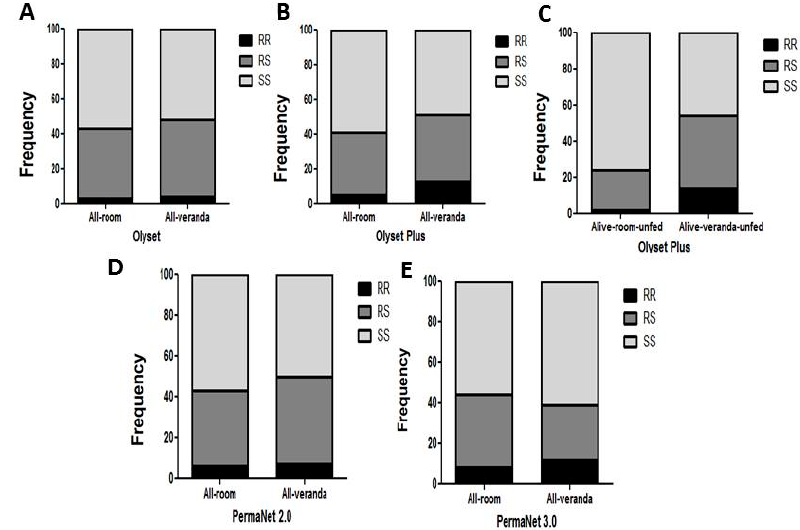
Figure 4. Impact of the L119F-GSTe2 mediated metabolic resistance on bednet efficacy -exophily: ( A ) Genotype distribution of L119F- GSTe2 between indoor (Room) and outdoor (verandah) mosquitoes after exposure to Olyset showing no association; ( B ) Genotype distribution of L119F- GSTe2 between indoor (Room) and outdoor (verandah) mosquitoes after exposure to Olyset Plus showing a significant increased ability to exit the room when considering all mosquitoes; ( C ) A greater association is observed with exophily with Olyset Plus when only analyzing unfed mosquitoes; ( D ) Genotype distribution of L119F- GSTe2 between indoor (Room) and outdoor (verandah) mosquitoes after exposure to PermaNet 2.0 showing a significant association (RS vs. SS: OR = 1.35; p < 0.01); ( E ) Genotype distribution of L119F- GSTe2 between indoor (Room) and outdoor (verandah) mosquitoes after exposure to PermaNet 3.0 showing no association. Table 6. Impact of L119F-GSTe2 mutation on the efficacy of various bed nets in repellency. Exophily